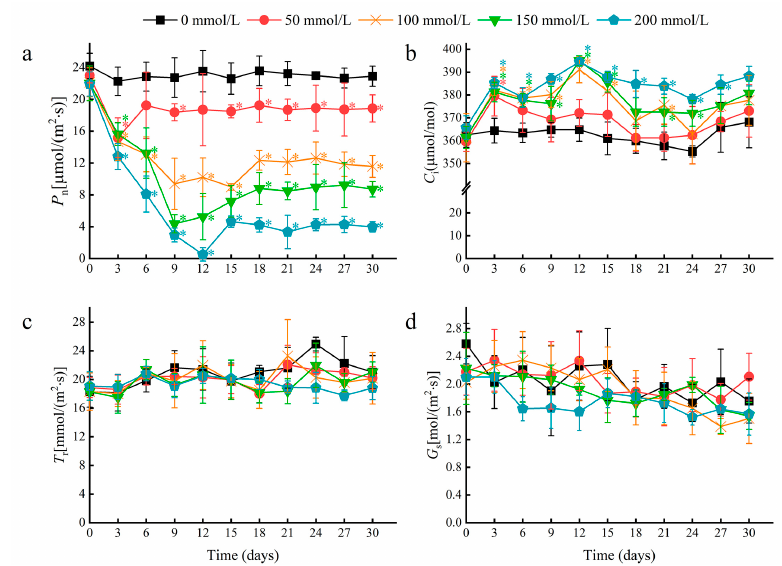
Figure 3. The effects of salt stress on photosynthetic parameters in water lily plants. ( a ) The net photosynthetic rate ( Pn ), ( b ) intercellular CO 2 concentration ( Ci ), ( c ) transpiration rate ( Tr ), and ( d ) stomatal conductance ( Gs ) in water lily plants subjected to salt stress over 30 days. Data are the means of ten biological replicates ( ± SDs). The asterisks represent statistically significant differences ( p < 0.05).